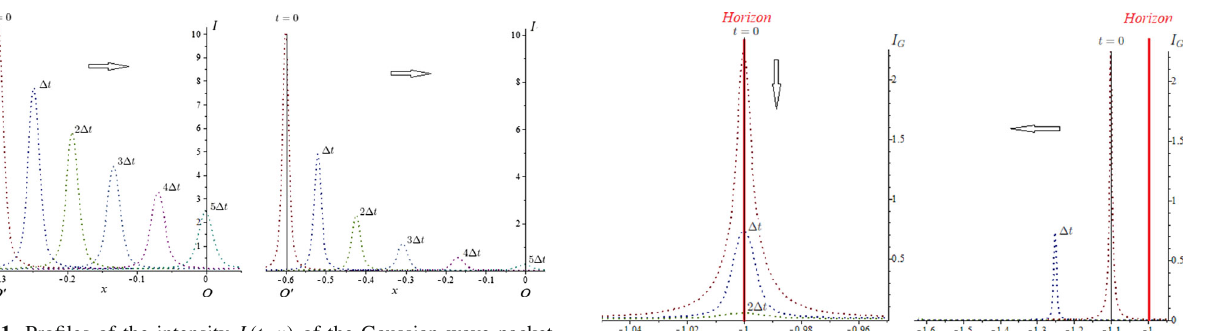
Fig. 1 Profiles of the intensity I ( t , x ) of the Gaussian wave packet prepared in O (cid:8) (with a 3 = 0 . 005 and ¯ k 3 = 100) as observed by O at consecutive epochs. In the left panel d = 0 . 3 and (cid:6) t = 0 . 0713, while in the right panel d = 0 . 6 and (cid:6) t = 0 . 1832